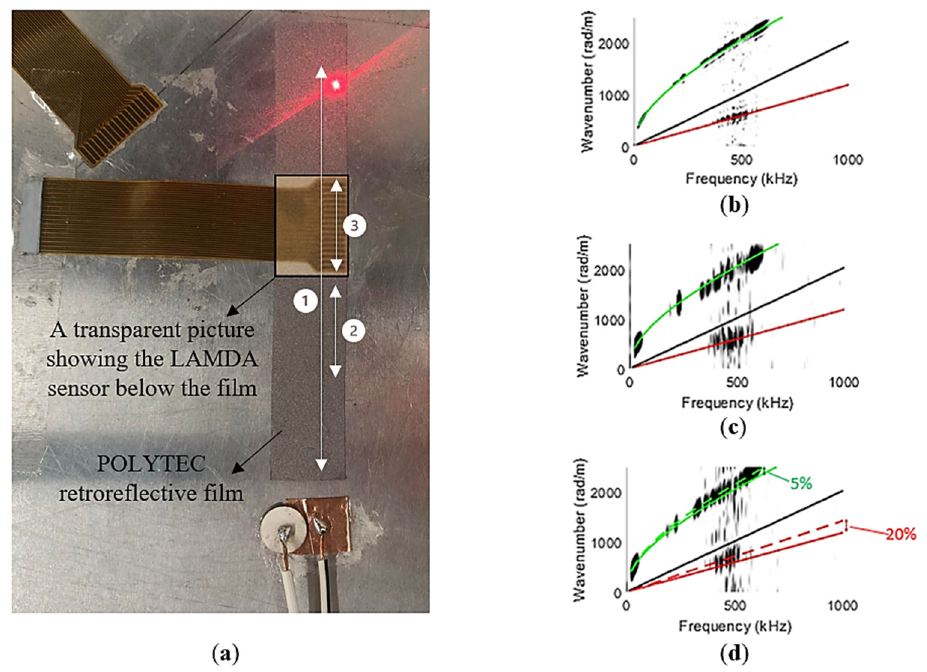
Figure 4. ( a ) Laser scanning routes labelled 1–3. Al5005 plate dispersion curve wavenumber versus frequency ( b ) of route 1 (80 mm); ( c ) route 2 (20 mm); and ( d ) route 3 (20 mm over LAMDA sensor).